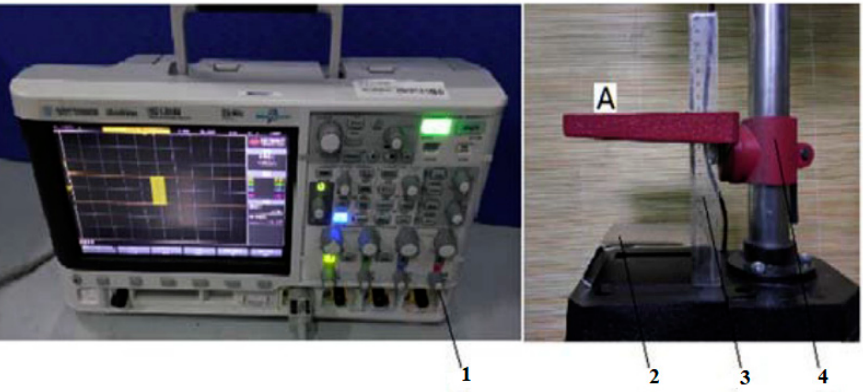
Figure 17. (a) Experiment test bench; (b) Grain release adjuster; (c) Sensing plate slide adjuster; (d) Sensing elements (1—support, 2—height adjustment mechanism, 3—position adjustment